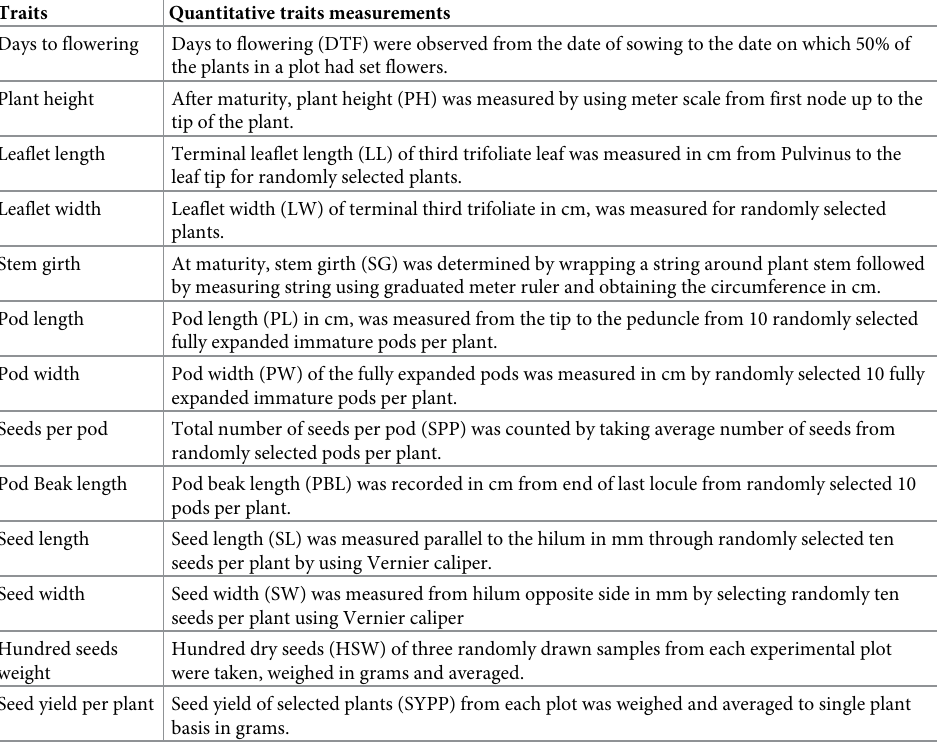
Table 2. List of investigated quantitative traits following International Board for Plant Genetic Resources list (IBPGR, 1982). Traits Quantitative traits